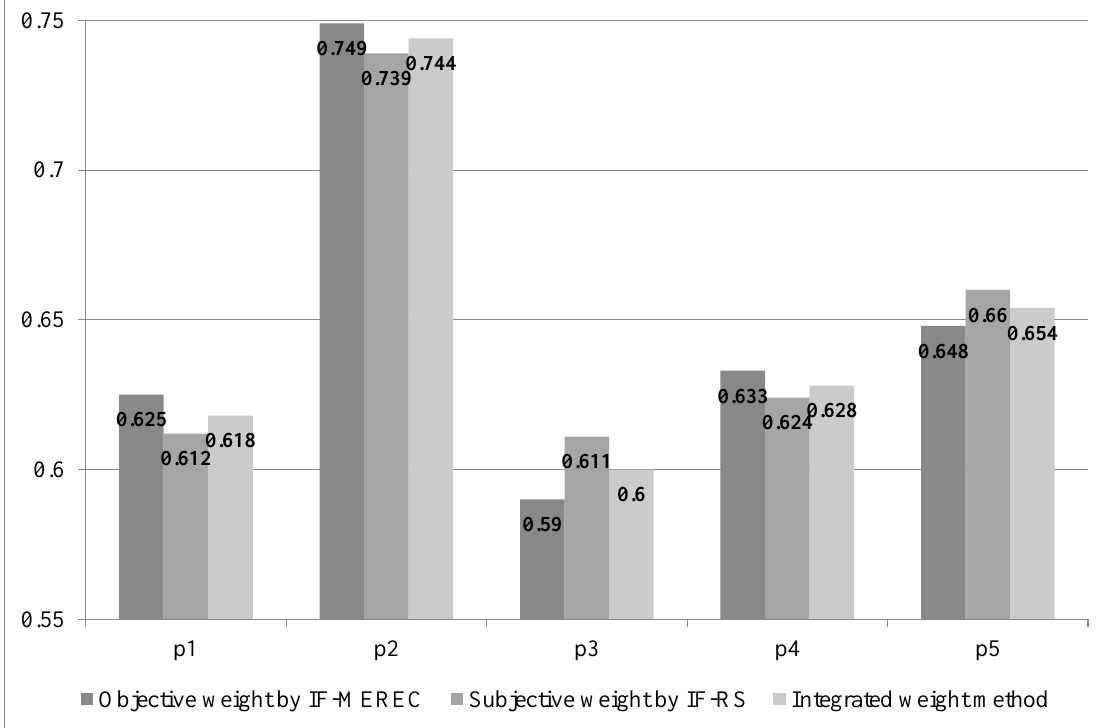
Figure 4. Sensitivity analysis for prioritizing the BESSs with different weighting procedures.